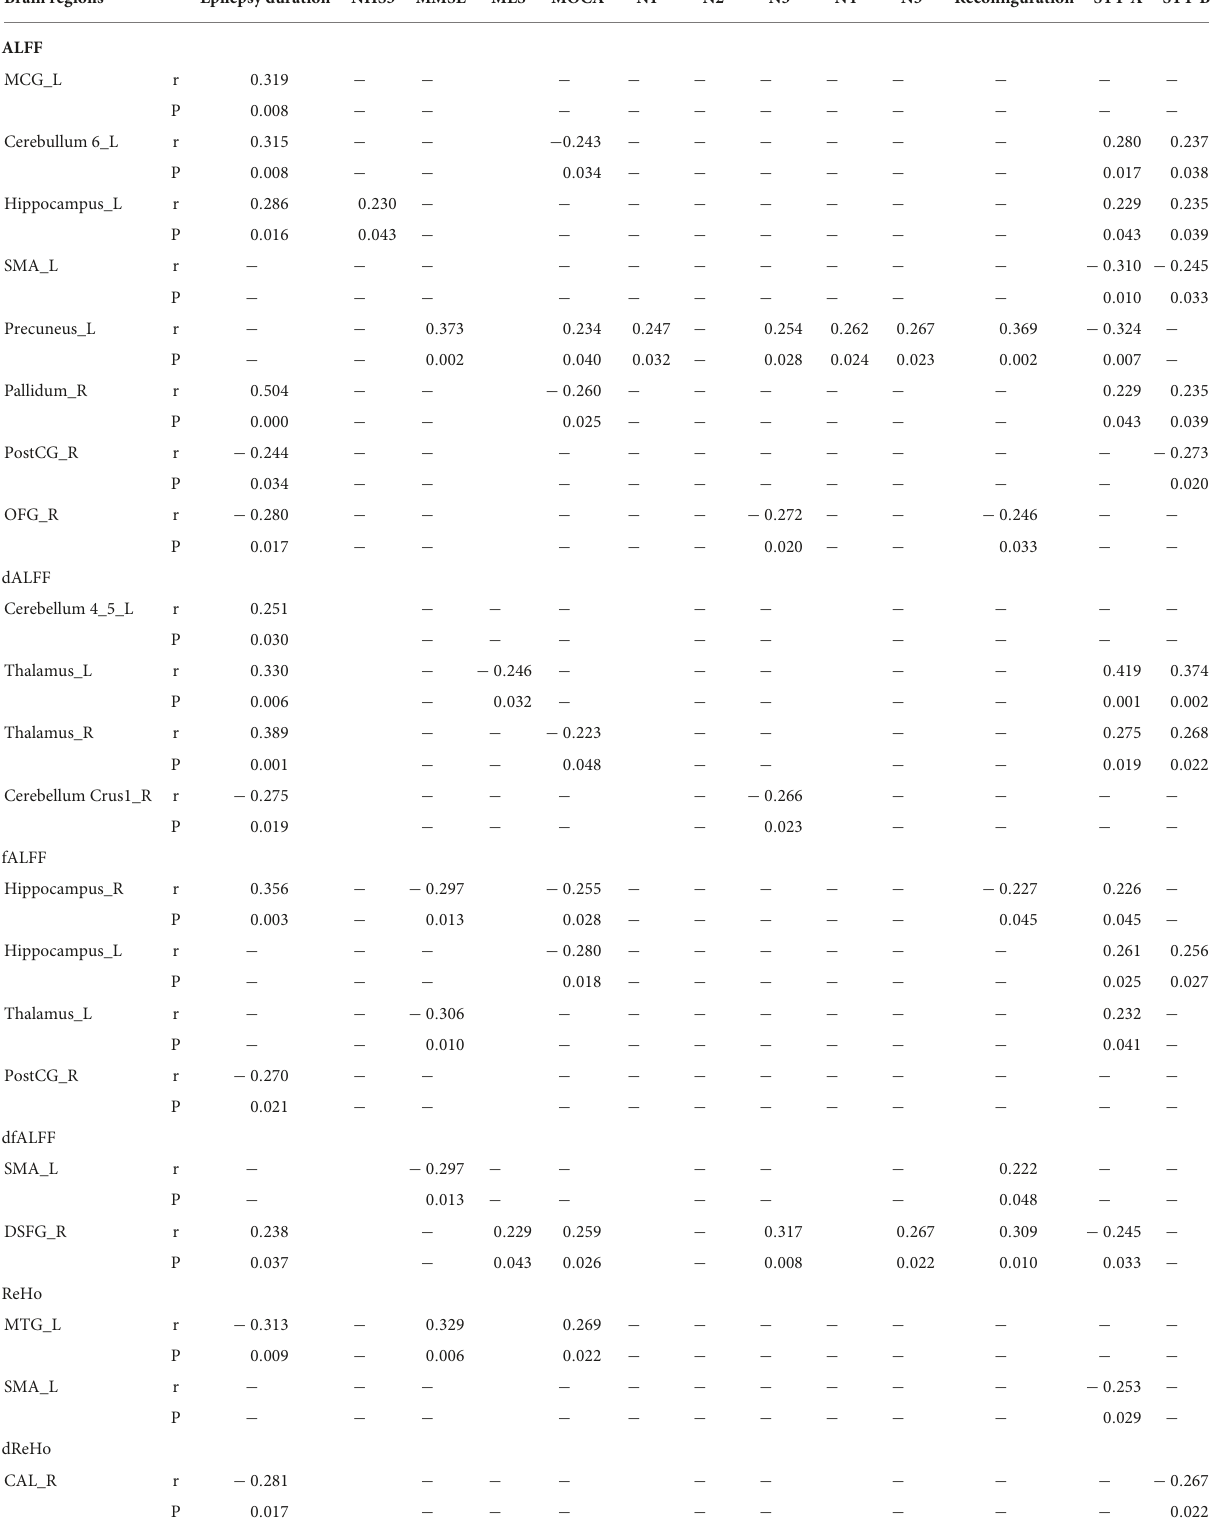
TABLE 3 Correlations between the values of IBA indicators in abnormal brain regions and epilepsy duration, NHS3, or cognitive scales scores. Brain regions Epilepsy duration NHS3